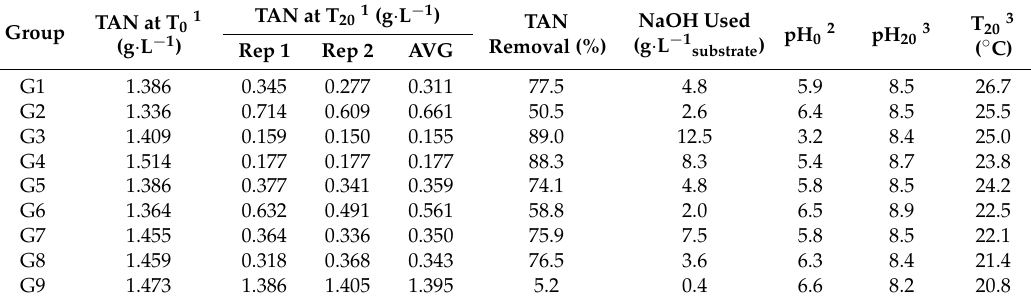
Table 3. Total Ammonia Nitrogen (TAN) removal performance of the different magnesium and phosphorus reagent combinations